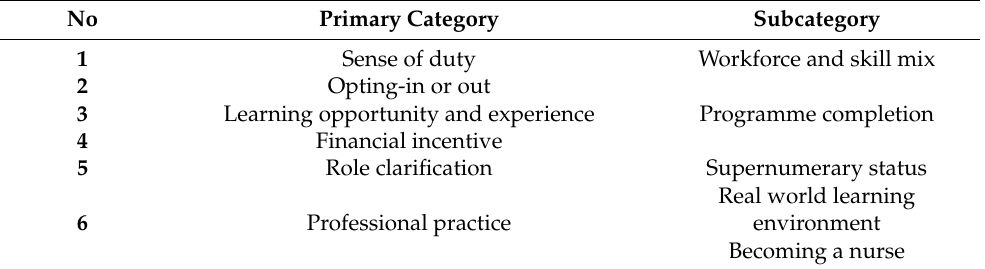
Table 6. Emergent themes and